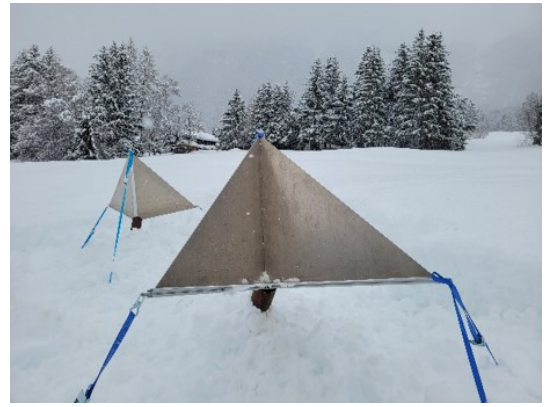
Figure 2. Corner reflectors installed in Chamonix valley,